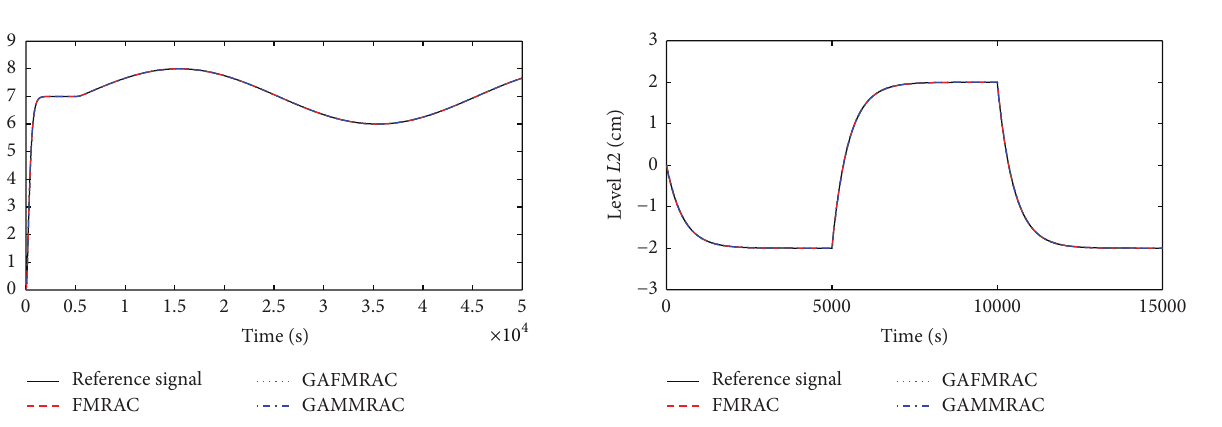
Figure 12: Response of the three controllers for a square wave command signal when 𝐺 𝑀3 (𝑠) is used as the reference